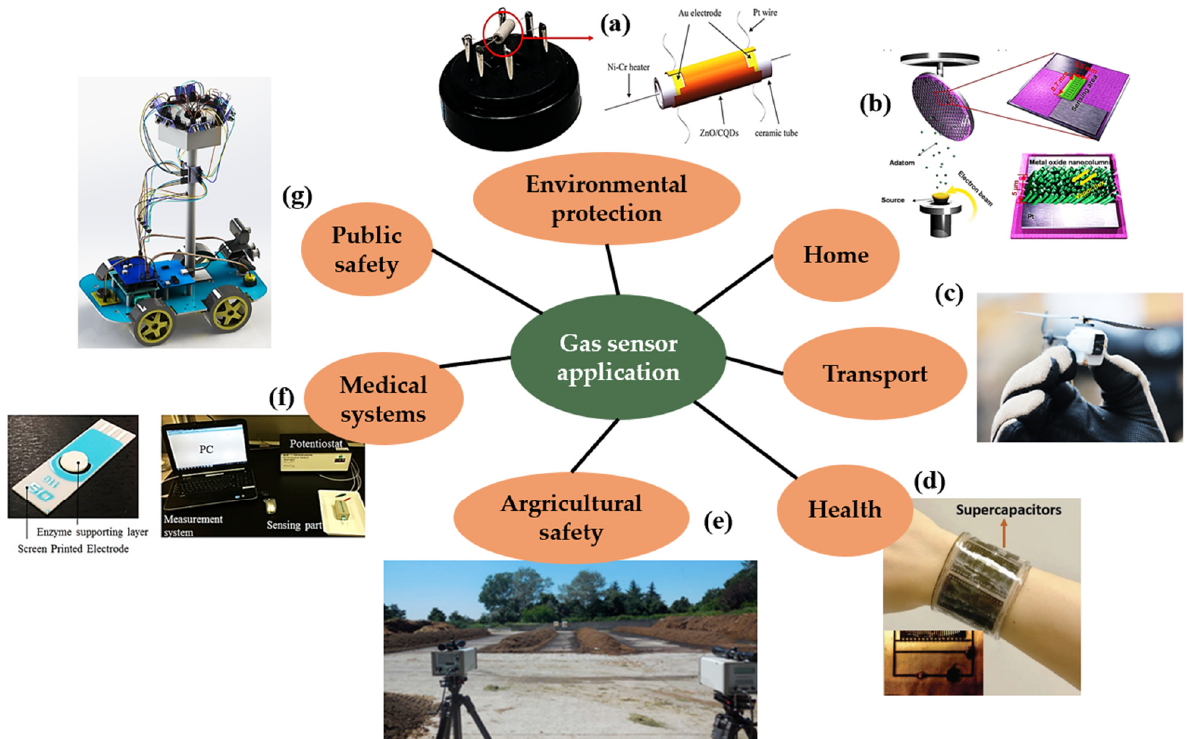
Figure 8. Semiconductor gas sensor applications. (Reprinted with permission from ref. [194]. Copy- right 2020 MV Nikolic et al): ( a ) NO gas sensor for environmental protection; ( b ) metal-oxide nano- columns sensor for fire detection; ( c ) smelling nano aerial sensor for gas source localization and mapping; ( d ) self-powered sensor wristband for health and fitness applications; ( e ) ammonia emis-